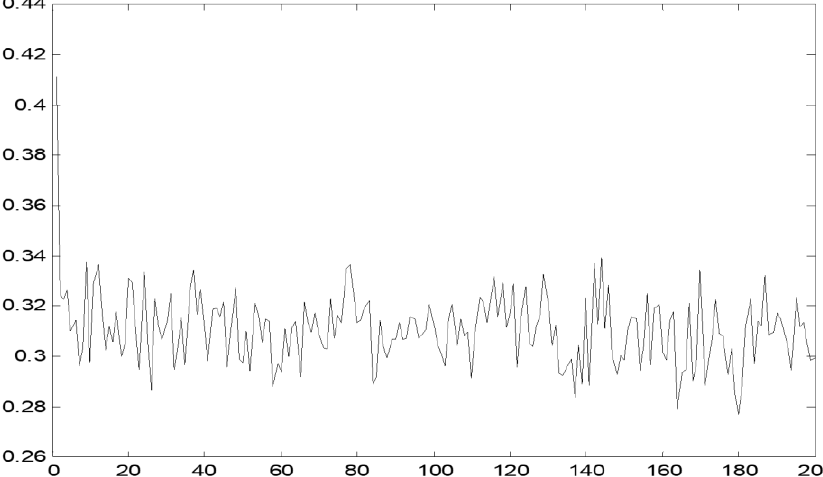
Fig. 6. Convergence of the answers obtained from the algorithm for the first objective function (satisfaction).